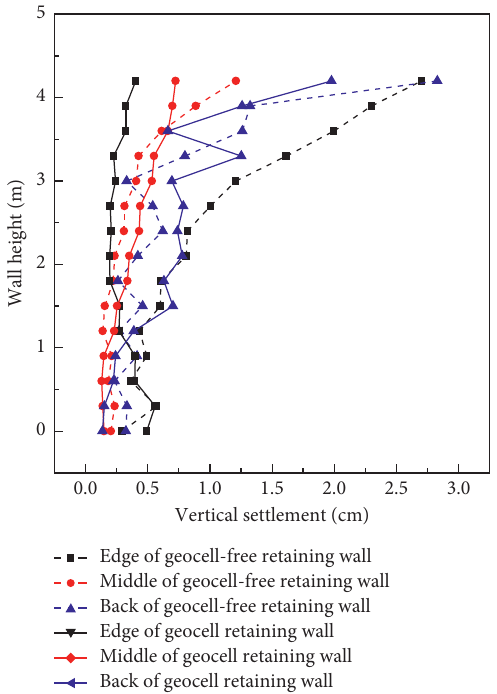
Figure 8: Horizontal displacement of the retaining wall. Figure